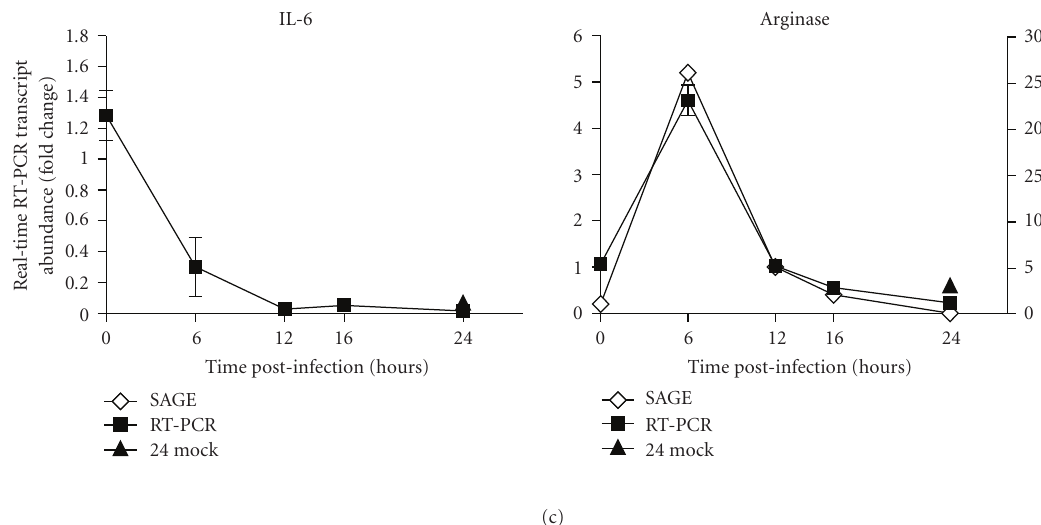
Figure 1: Real-time RT-PCR validation of SAGE results. Validation by real-time RT-PCR on RNA from the in vitro PRRSV-infected PAMs samples used in the SAGE analysis of selected transcripts showing di ff erential transcript abundance. Real-time RT-PCR transcript abundance results (filled squares; left y -axis) expressed as the mean fold increase ± SEM in gene expression ( n = 3) relative to mock-infected cells and SAGE tag counts normalized to total tags per library (open diamonds; right y -axis) are shown for transcripts. The “24 mock” result shows the real-time RT-PCR fold change in transcript abundance as a result of being in cell